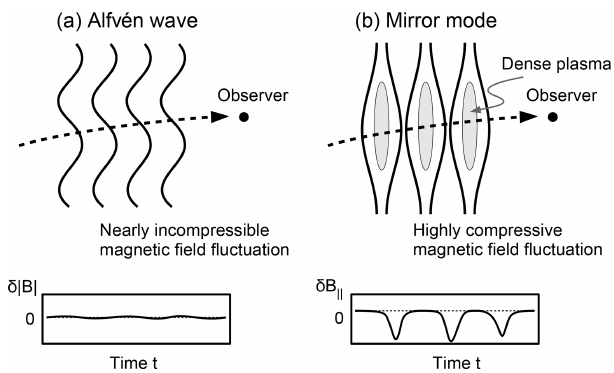
Figure 1. Schematic illustration of (a) Alfvénic fluctuations and (b) mirror mode fluctuations. The bottom panels show the in situ (a) magnetic magnitude fluctuations, δ | B | and (b) mean (back- ground) magnetic field fluctuations δ | B || | of a virtual spacecraft crossing the respective